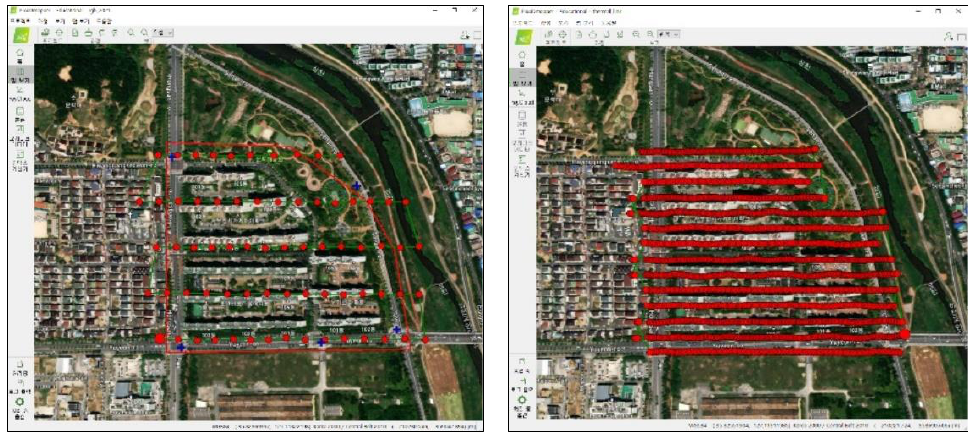
Figure 6. Number of images taken by each camera.